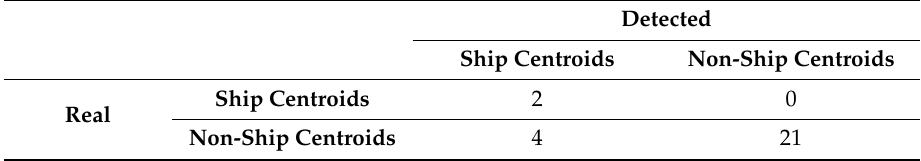
Table 1. The confusion matrix of real and detected ship centroids using the improved Otsu TSM.